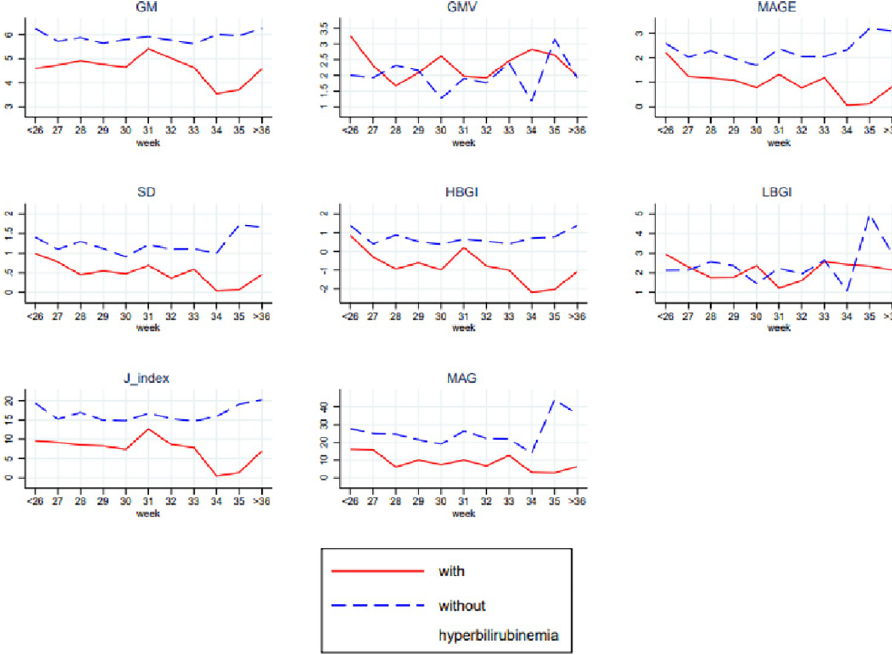
Fig 3. Trends in parameters of glycaemic variability by neonatal hyperbilirubinemia. GM = Glycaemic Mean; GMV = Glycaemic Mean Value; HBGI = High Blood Glucose Index; LBGI = Low Blood Glucose Index; MAG = Mean Absolute Glucose; MAGE = Mean Amplitude of Glucose Excursions; SD = Standard Deviation. Adjusted values reported (see the Statistical analysis sub-section for details).